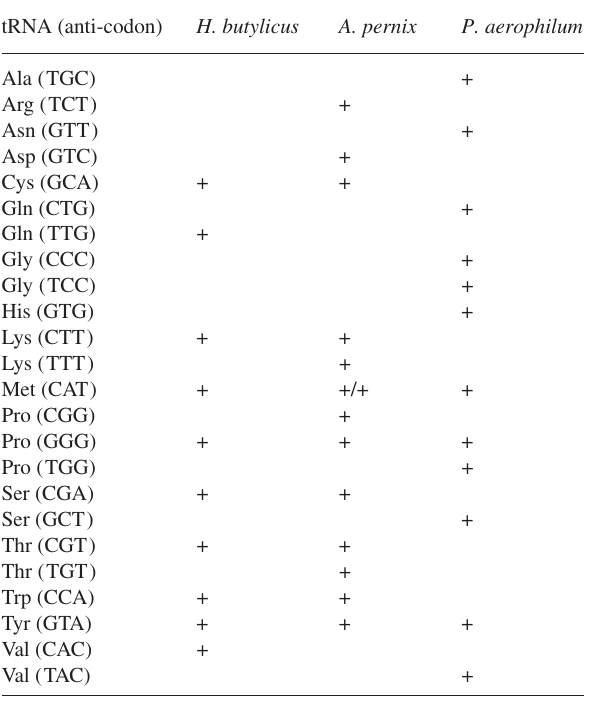
Table 1. Comparison of intron-containing